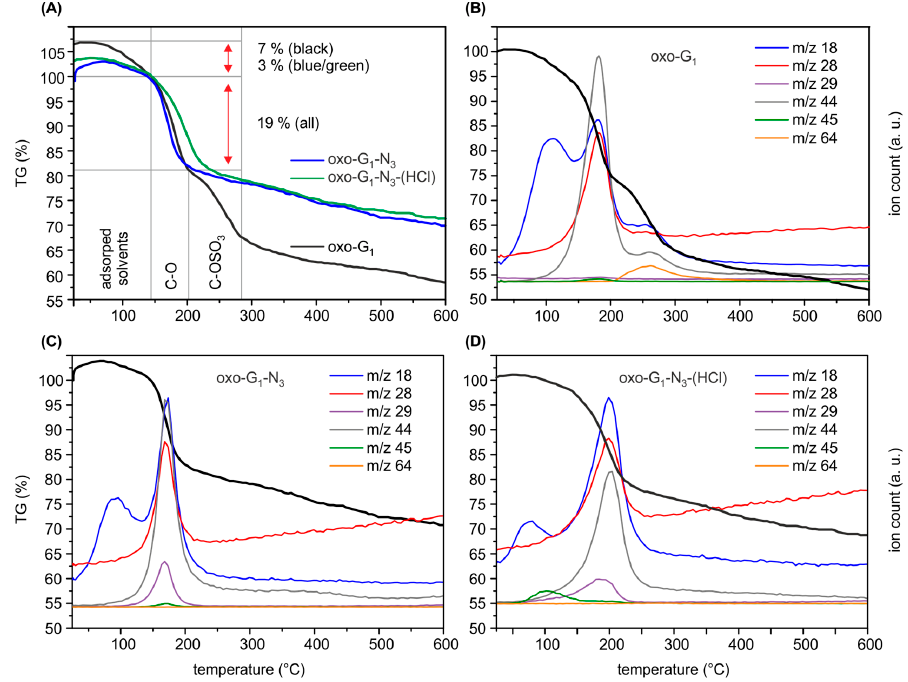
Figure 2. ( A ) Comparison of thermogravimetric analysis (TGA) results of oxo-G 1 (black), oxo-G 1 - 15 N 3 (green) and oxo-G 1 - 15 N 3 -(HCl) (blue); ( B ) TGA results of oxo-G 1 with m / z traces of the most important peaks ( m / z 18: H 2 O; m / z 28: CO 2 ; m / z 29: 15 N 14 N; m / z 44: CO 2 ; m / z 45: H 3 CCOH + -fragment of 2-propanol and m / z 64: SO 2 -fragment from organosulfate); ( C ) TGA results of oxo-G 1 - 15 N 3 ; ( D ) TGA results of oxo-G 1 - 15 N 3 -(HCl).